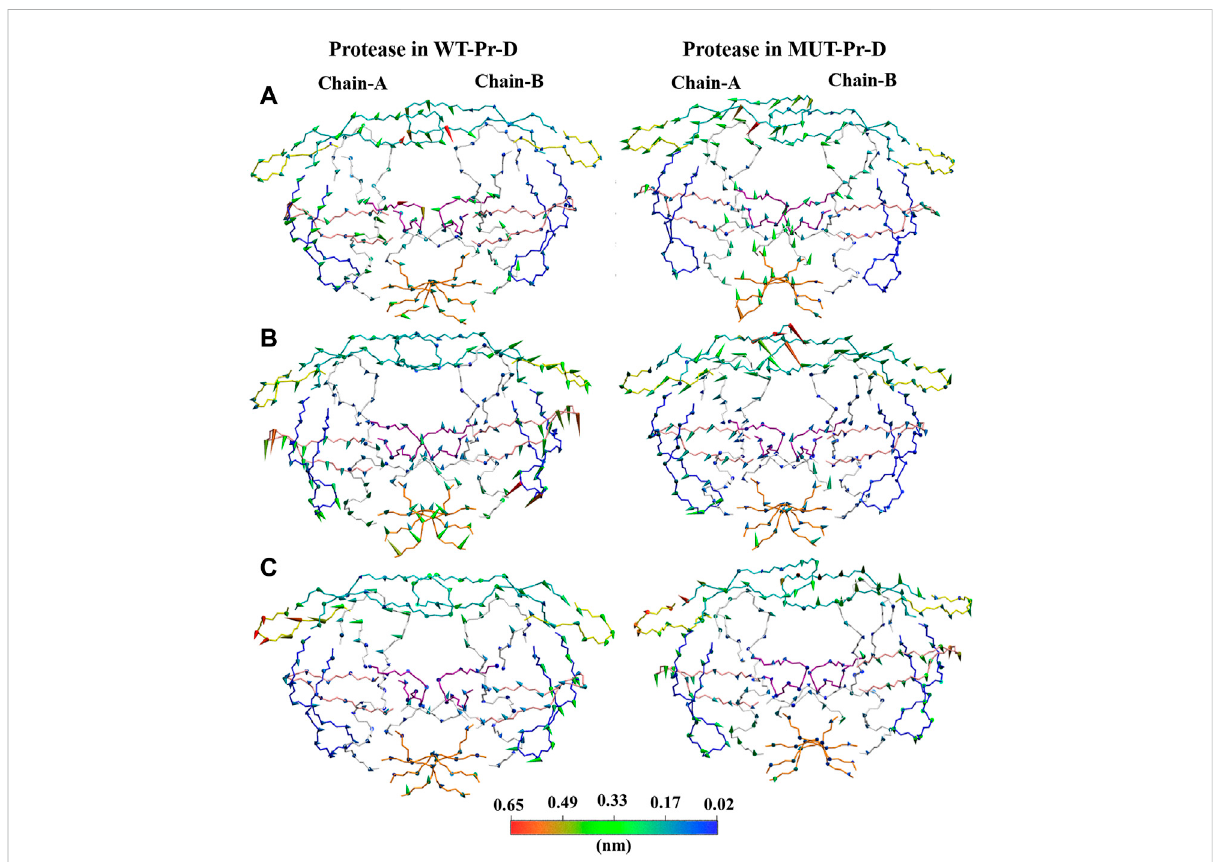
FIGURE 4 Projectionsofmotions along fi rst[ (A) ;PC1],second[ (B) ;PC2]andthird[ (C) ;PC3]eigenvectorsforC α atoms ofWT-Pr-DandMUT-Pr-D.DRVis notshowninthepicture.Theproteasessegmentsaredepictedindifferentcolors;theactivesitebypurple,the fl ap-elbowsbyyellow,the fl ap-tipsby cyan,thefulcrumsbypink,thecantileversbyblue,andtheinterfacesbyorangecolors.Thedirectionoftheconesdescribesthedirectionofmotions and their lengths are correlated with the magnitude of motions, which was also indicated by the color gradient